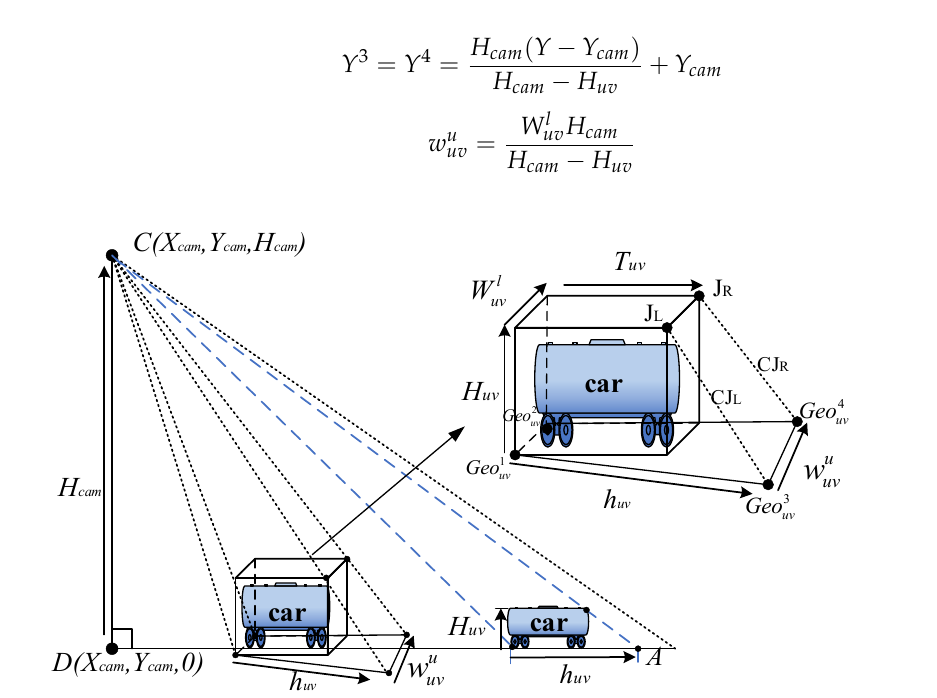
Figure 3. Illustration of object projection width.